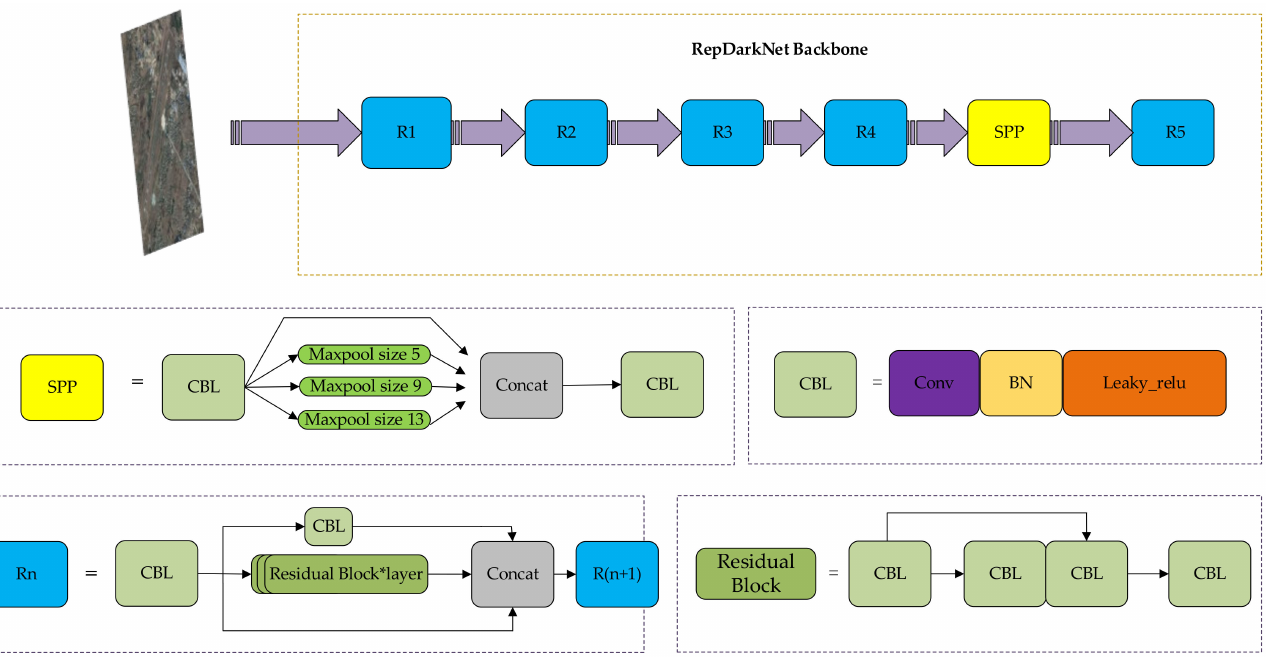
Figure 2. Details of backbone network. In Rn, when n = 1, layer = 1; when n = 2, layer = 2; when n = 3 or 4, layer = 8; and when n = 5, layer = 4. The purple arrow represents the connection between R n and R n + 1 blocks, the output information of R n is the input information of R n + 1